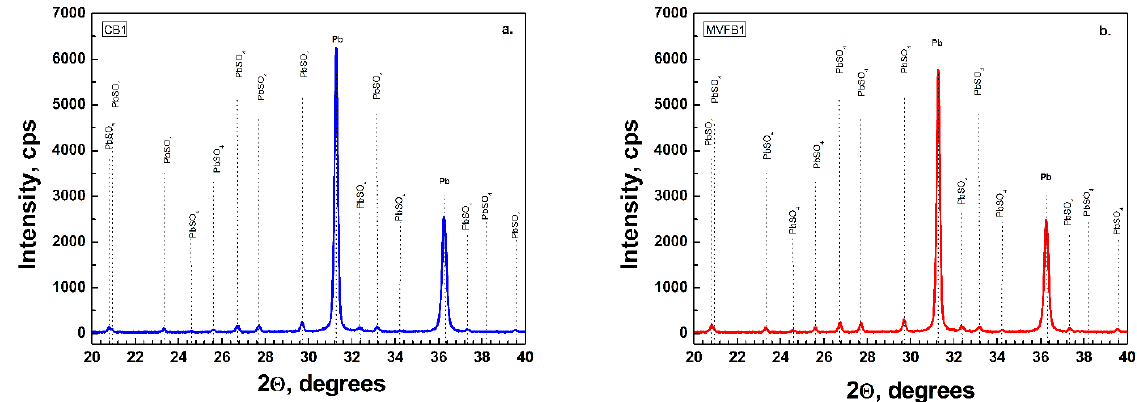
Figure 5. XRD analysis of control battery ( a ) and battery formed with external application of multivector field ( b ) after formation. Table 7. Chemical analysis of the negative active materials after formation.